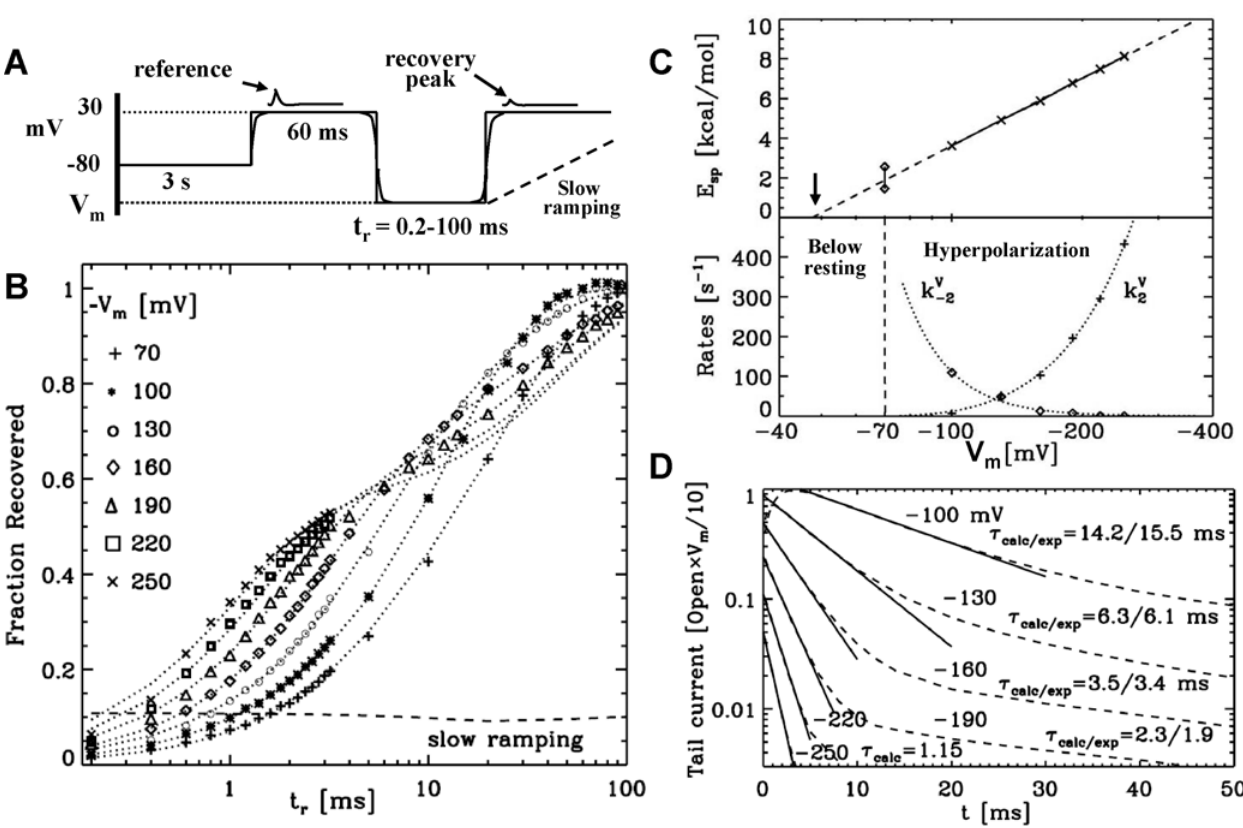
Figure 2. Time course of recovery of a whole-cell Drosophila Shaker K + channel. (A) Experimental conditions are taken form Ref. [14]. Oocyte was equilibrated for 3 s at 2 80 mV in 150 mM external K + , and pulsed twice to + 30 mV for 60 ms. The intervening gap between the two pulses is set at various repolarization membrane potentials V m between 2 70 to 2 250 mV for a time t r , which is lengthened by 0.2 ms. A slow ramping potential is also sketched. The currents in the second pulse are used as a measure of the extent of recovery from inactivation relative to the first pulse. The model assumes voltage reversal to be instantaneous. To account for this artifact, peak currents are calculated 1 ms after depolarization. (B) Experimental (symbols [14]) and predicted (dotted lines) fraction recovered of ion currents as a function of t r . The fraction is defined as the ratio of the maximum current from the second and first pulse after subtracting the background corresponding to the current at the end of the reference peak. Predictions follow from solving the kinetic scheme in Fig. 1, and assuming that the currents at V m = + 30 mV are proportional to the concentration of open channels. (C) Model parameters: (Top panel) Elastic energy E sp of the peptide linker as a function of V m , arrow points to the threshold voltage below which the blocking rates are predicted to be voltage independent (as in Fig. 1B); Bottom panel: on and off rates k 6 2 between repolarization (R) and hyperpolarization (H) substates, dotted lines are a guide to the eye. (D) Inward tail currents (dashed lines). For clarity, currents are plotted as the concentration of open channels (RO + HO) times their corresponding voltage. The data is taken from the simulations resulting in Fig. 2B (right at the onset of the second pulse). Solid lines are linear fits used to calculate the time constants and comparison with experiments is noted [14]. For consistency, we disregarded minor differences with the experiment. Namely, in the experiment the first pulse was set to + 60 mV for 30 ms , instead of + 30 mV and 60 ms in Fig. 1A.